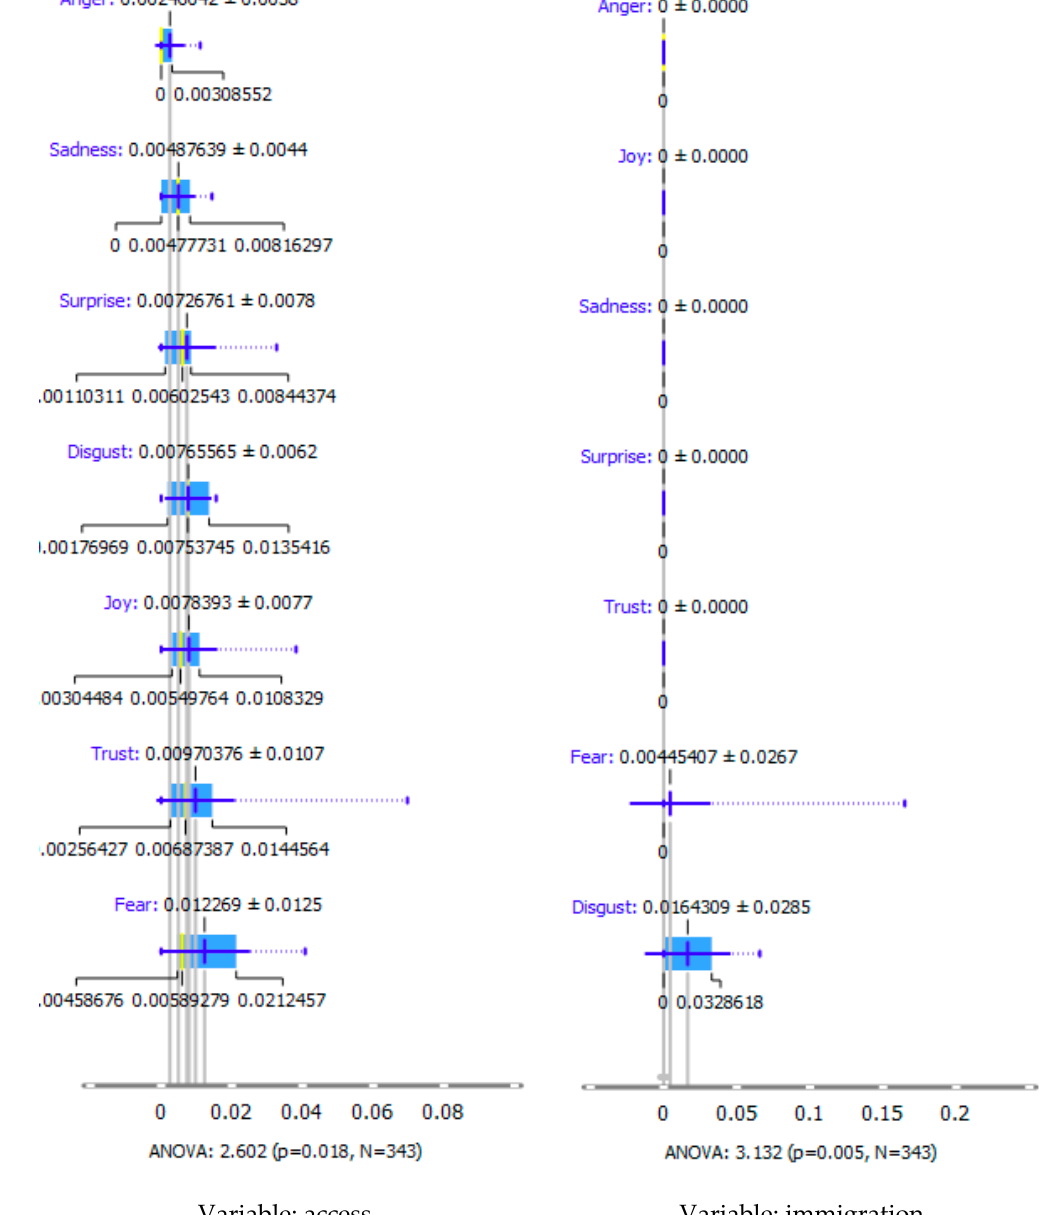
Figure 7. Emotion recognition for health migration in rare diseases with access and immigration. Source: own elaboration based on 343 references [44–386].